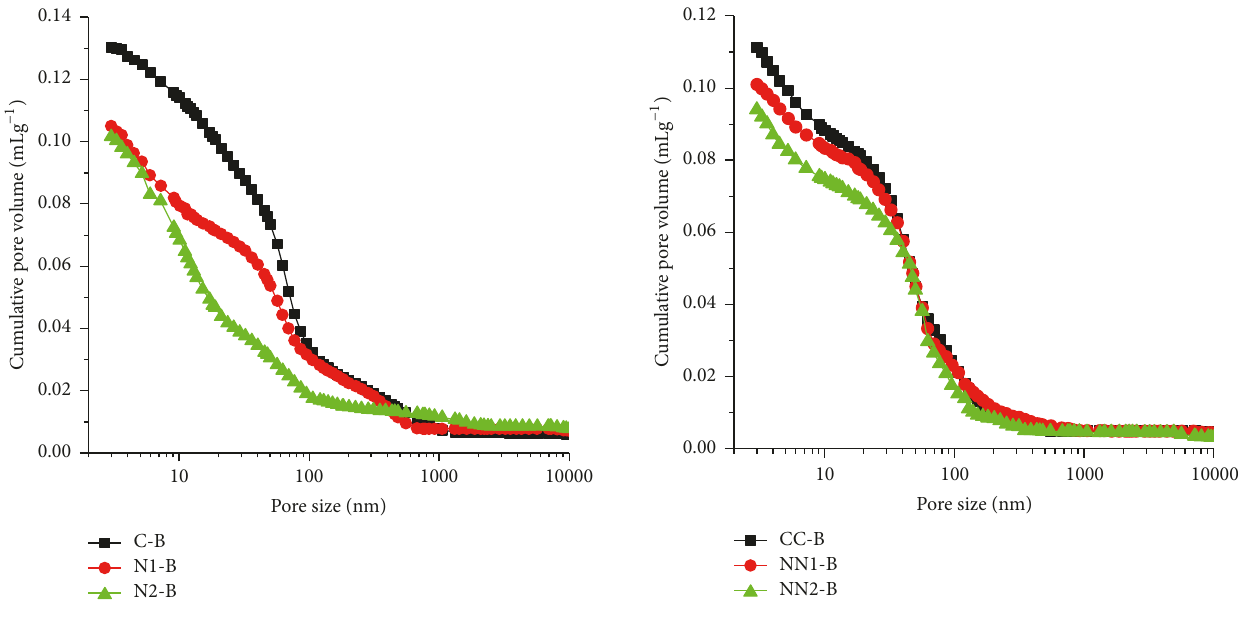
Figure 12: Pore structures of the standard-cured hardened paste with W/B of 0.4 at the age of 90d.